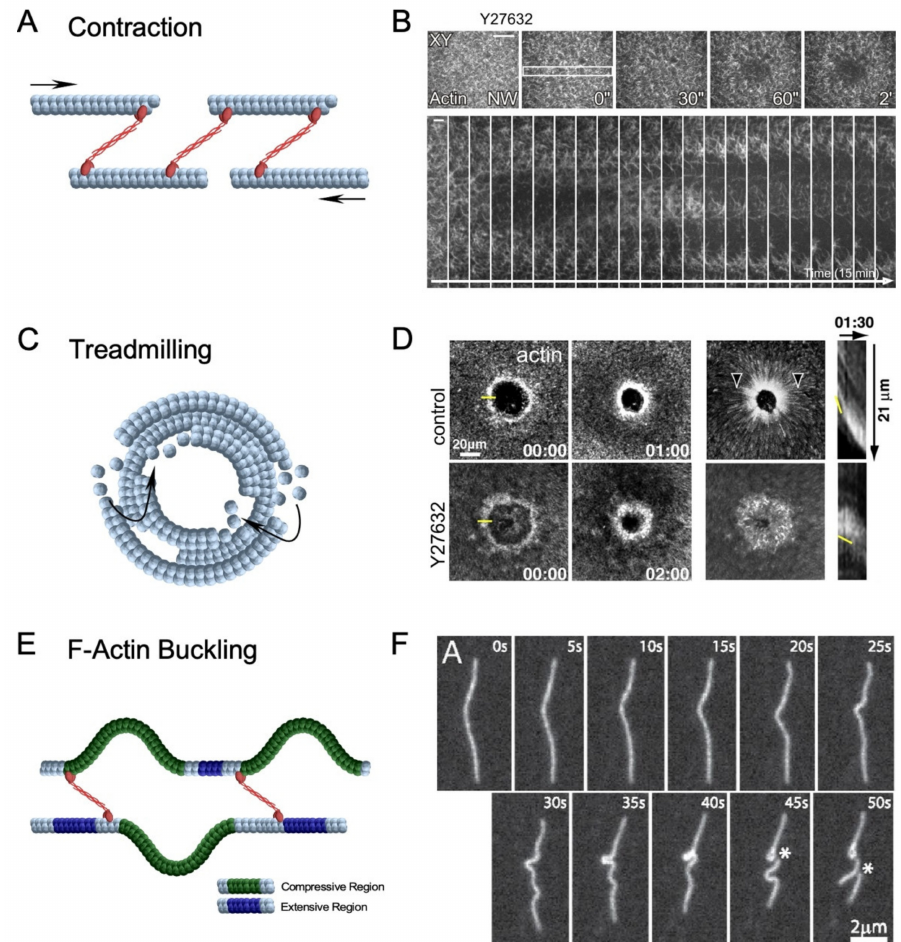
Figure 5. Diverse mechanisms of actin filament network contractility. ( A ) Schematic diagram depicting sarcomeric-like contraction involving non-muscle myosin II can pull actin filaments and close a wound. Arrows depict opposing movement of actin filaments. ( B ) XY and kymograph confocal micrographs of laser injured Drosophila syncytial embryos expressing a fluorescent actin reporter and treated with Y27632, a potent ROK inhibitor to inactivate myosin is unable to close a wound. Yellow rectangle shows region of the image used to generate the kymograph. Used with permission from Abreu Blanco et al., (2011), J. Cell Biol. 193(3): 455–464. doi: 10.1083/jcb.201011018 [9]; permission conveyed through Copyright Clearance Center, Inc. ( C ) Schematic diagram